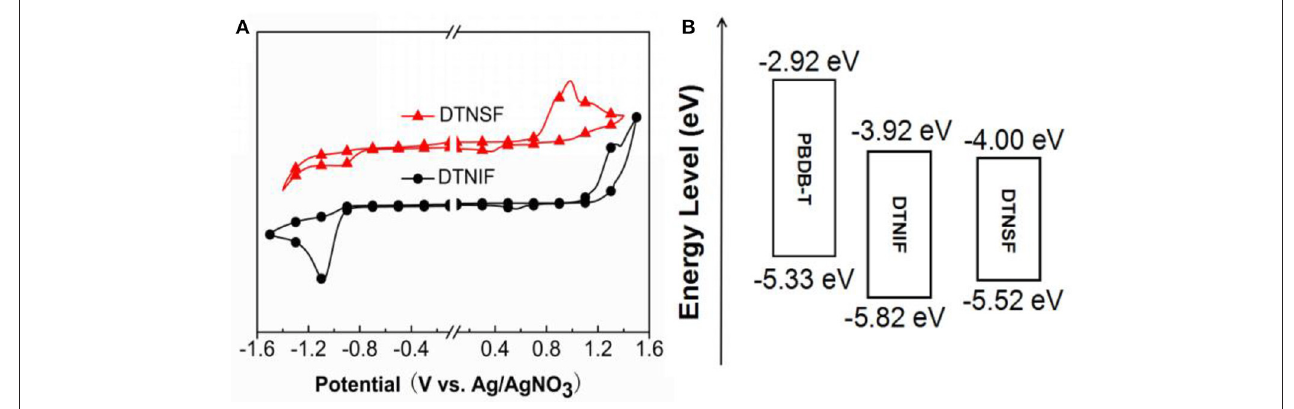
FIGURE 3 | (A) Cyclic voltammograms of DTNIF and DTNSF. (B) Estimated energy level diagram of DTNIF, DTNSF, and PBDB-T.